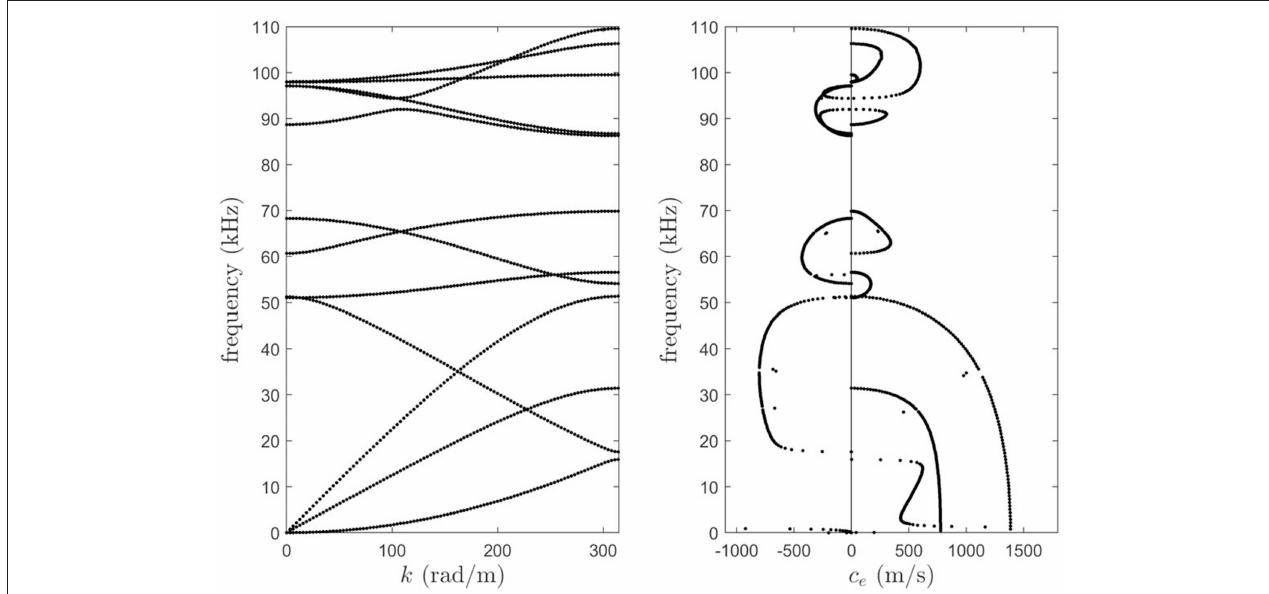
Figure A 1 | Band diagrams of the wavenumber k (Left) and energy velocity c e (Right) vs. frequency for the PC plate in the undeformed configuration reported in Figure 2A .